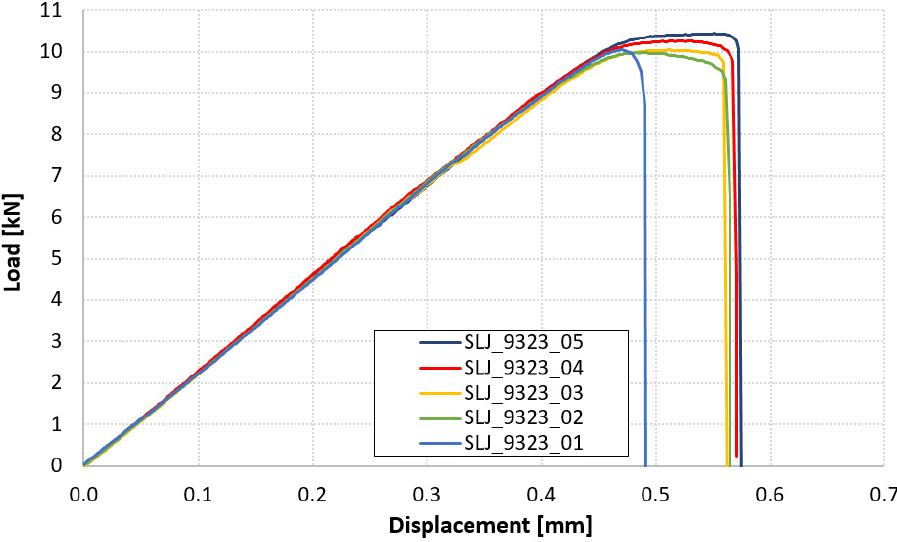
Figure 8. Force-displacement results of SLJ_9323 tests.